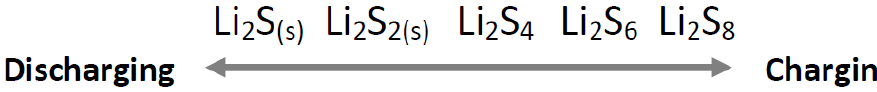
Figure 7. Lithium polysulfides in LSBs during charge/discharge cycle.